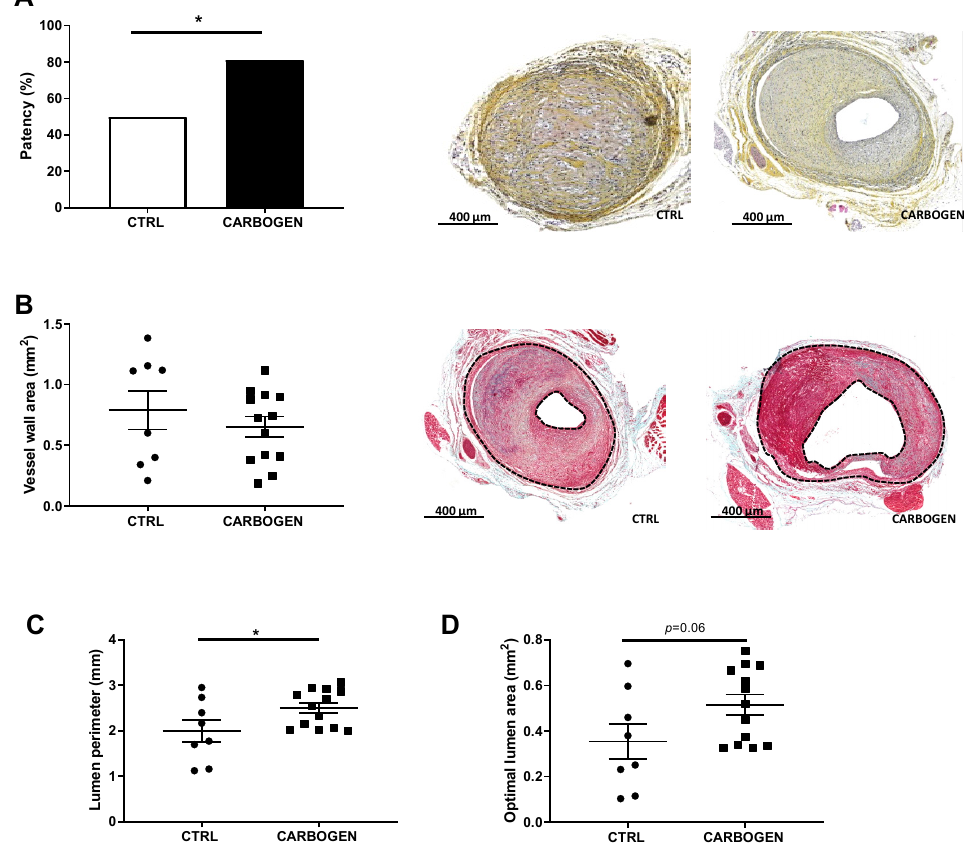
Figure 4. Chronic exposure to carbogen plays a protective role against vein graft occlusions. ( A ) Quantitative measurement of vein graft patency in ApoE3*Leiden mice from the control and prolonged carbogen treated groups. Data are analyzed by Chi-square test. * p < 0.05. Representative pictures of non-patent and patent vein grafts in ApoE3* Leiden mice at day 28 after surgery in the right panel. ( B ) Quantitative measurements of vein graft thickening. In the right panel, representative pictures of MOVAT staining in vein grafts from control ( n = 8) and long term carbogen treated mice ( n = 13), with vessel wall area as the area between the two dotted lines. ( C ) Quantification of lumen perimeter and ( D ) optimal lumen area. Data are presented as mean ± SEM. * p < 0.05; by two-sided Student’s t test.